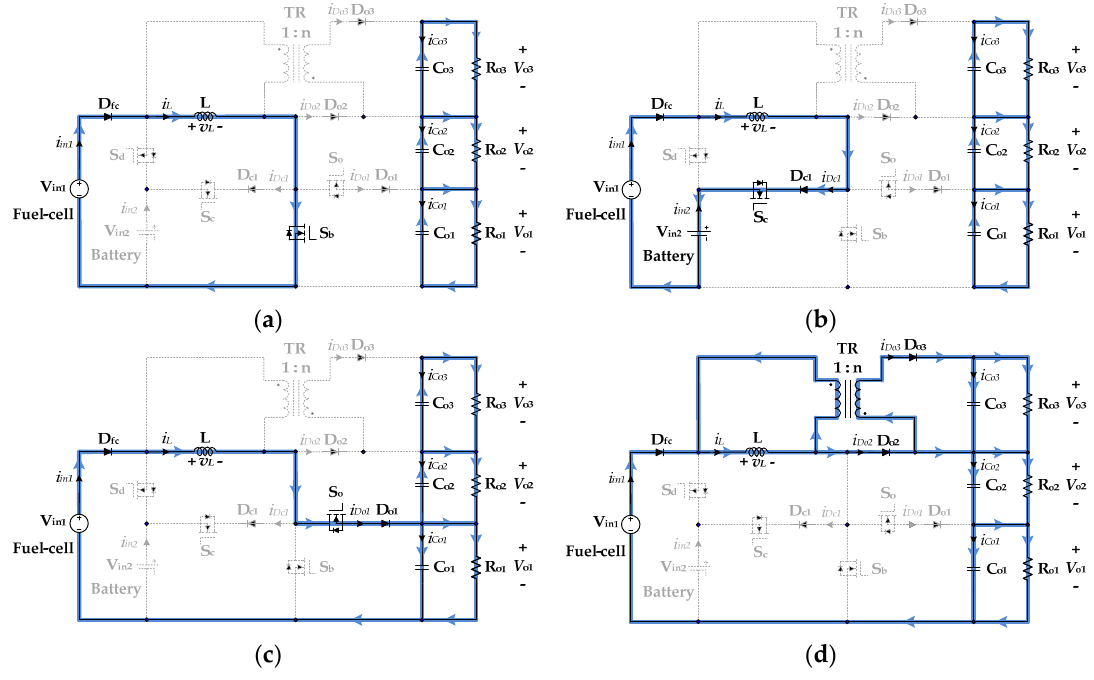
Figure 5. Equivalent circuits of the battery charging mode: ( a ) State 1 (0 < t < D b T ); ( b ) State 2 ( D b T < t < D c T ); ( c ) State 3 ( D c T < t < D o T ); and ( d ) State 4 ( D o T < t < T ).